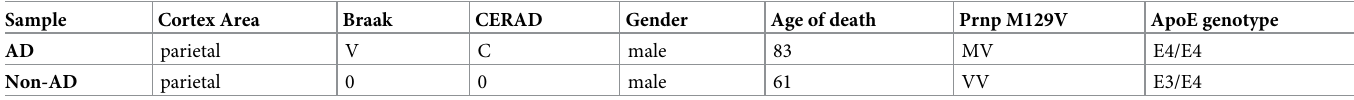
Table 1. Brain samples used for the